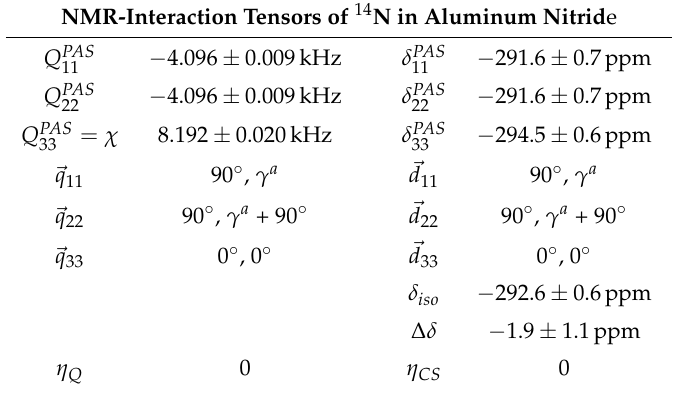
Table 2. Quadrupole coupling tensor Q N (left), and chemical shift tensor δ N (right) of 14 N in the wurtzite structure of AlN, as determined from single-crystal NMR experiments. The orientation of the corresponding eigenvectors are listed in spherical coordinates ( θ , ϕ ) in the hexagonal abc crystal frame CRY . The errors of the experimental values reflect those delivered by the fitting